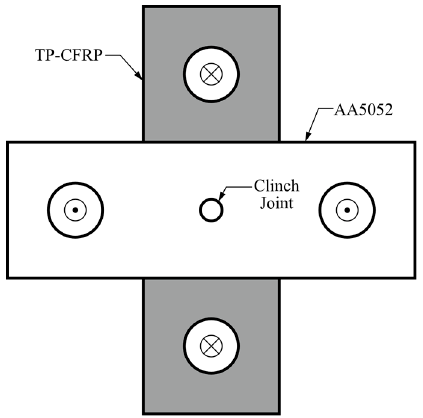
Figure 5. A cross-tension (CT) specimen with a clinch joint made of AA5052-H32 and TP-CFRP sheets. The white plate is made of AA5052-H32 and the gray plate is made of TP-CFRP. Both plates have 50.8 mm width and 152.4 mm length. Two circular holes located at the ends of each plate have 20 mm diameter. The overlap region at the specimen center has 50.8 mm width and 50.8 mm length. The cross and dot symbols marked at the center of four circular holes indicate the applied load directions.